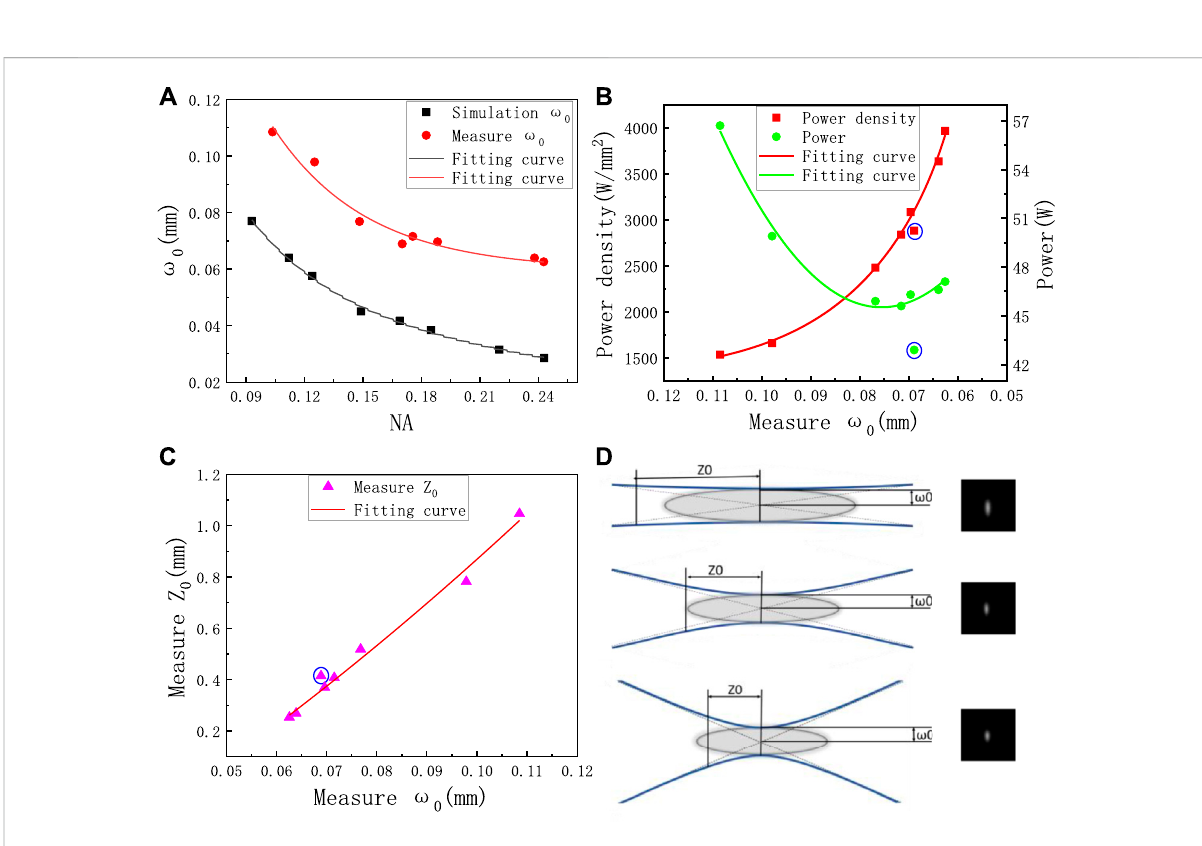
FIGURE 3 (A) Plot of the beam waist radius versus NA under simulation and the actual measurement; (B) effect of on the threshold power and its density; (C) relationship between and Rayleigh length at the focal point; (D) schematic diagram of laser focusing and the formed plasma morphology under different NA values, with insets showing the plasma images collected under different NA